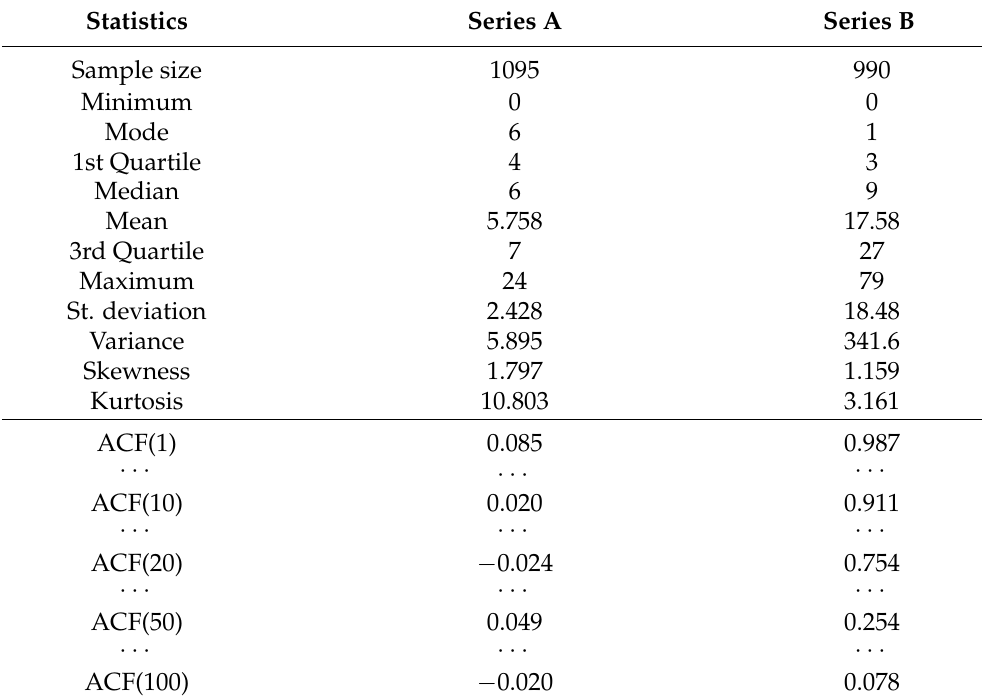
Table 4. Summary statistics of the total number of deaths per day before and after the appearance of the COVID-19 disease in the Republic of